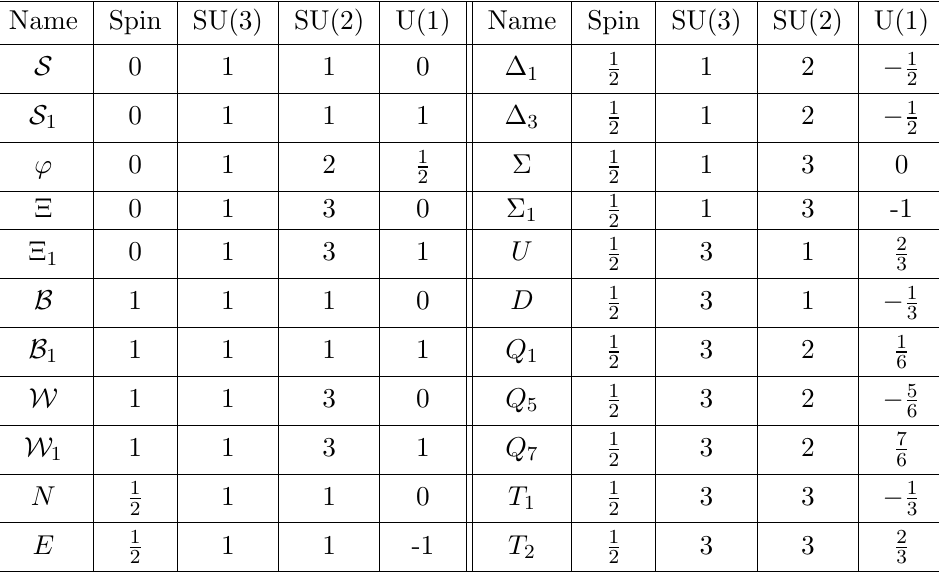
Table 6. Single-(cid:12)eld extensions of the SM constrained by our